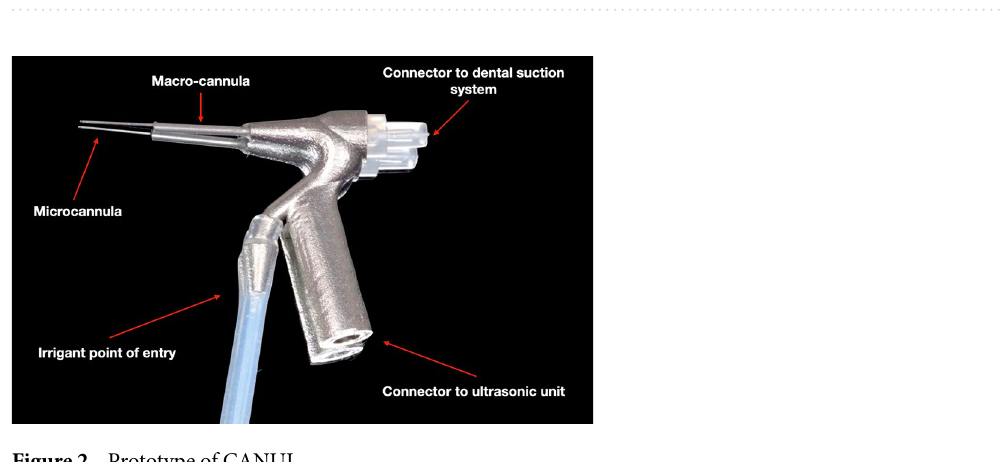
Figure 1. Representation of CANUI design and mode of operation.